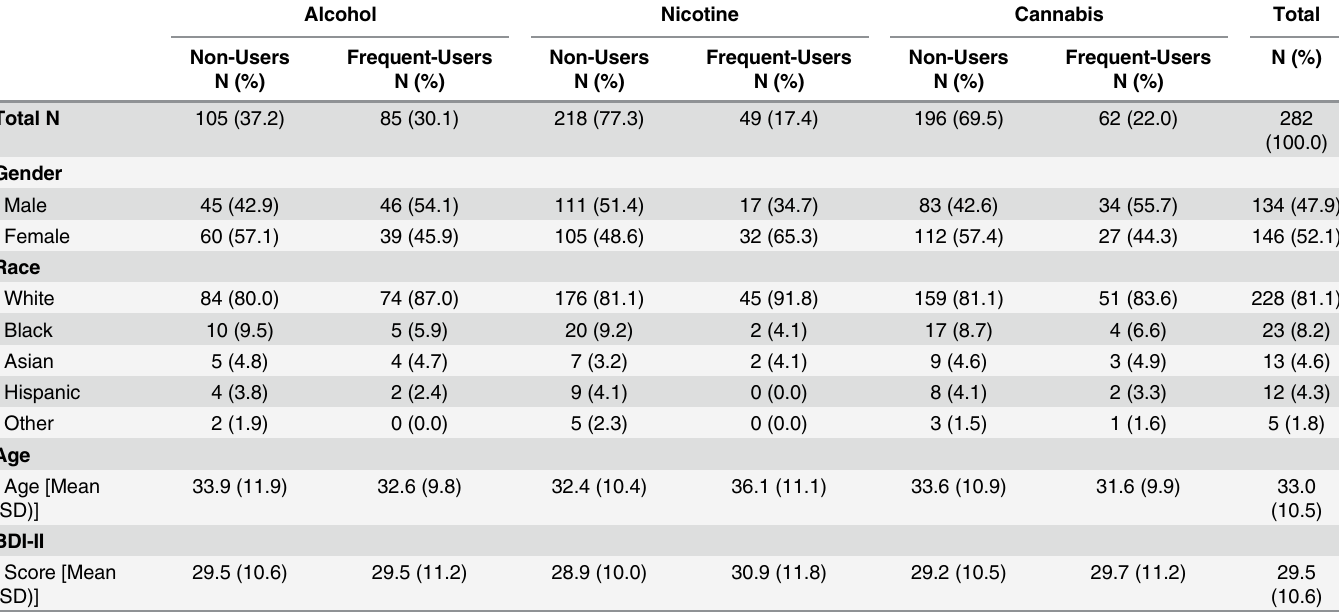
Table 1. Sociodemographic characteristics and Beck Depression Inventory means for non-users and frequent-users of alcohol, nicotine and can- nabis. Total and stratified by substance use